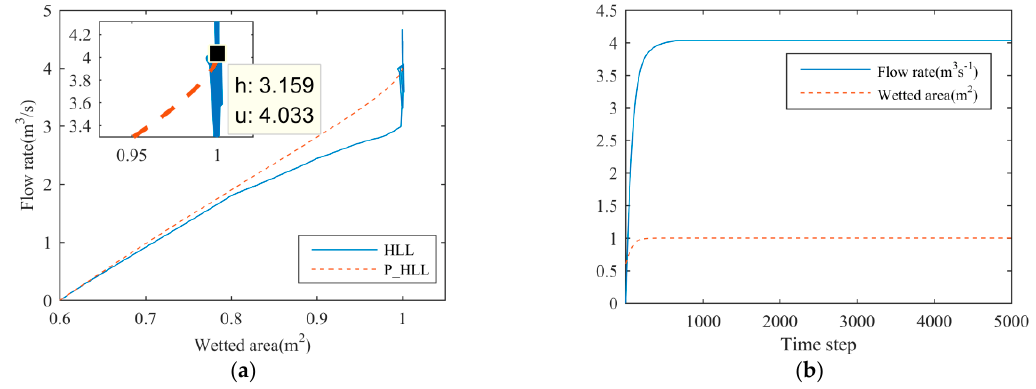
Figure 10. ( a ) Locus of the flow states in cell i + 1 simulated by HLL and P_HLL ( P a = 5, P b = 0.7); ( b ) history of the flow states in cell i + 1 simulated by P_HLL ( P a = 5, P b = 0.7).